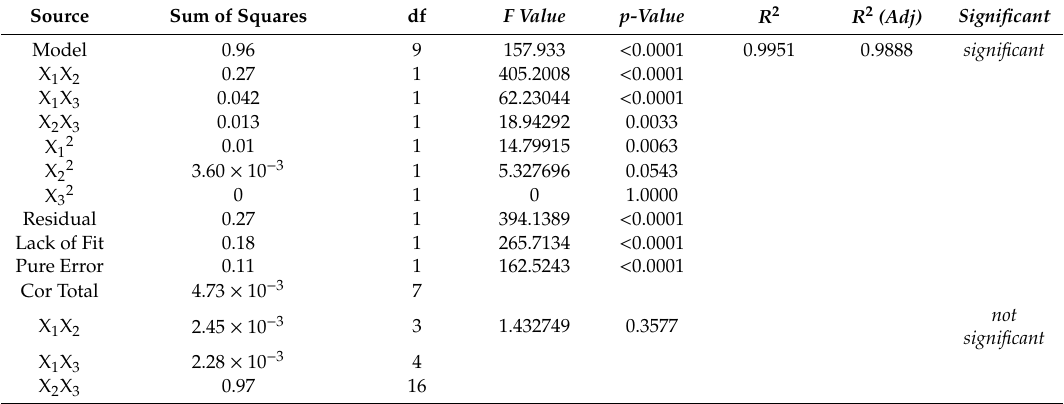
Table 1. ANOVA for the fitted secondary order curve for AME content.